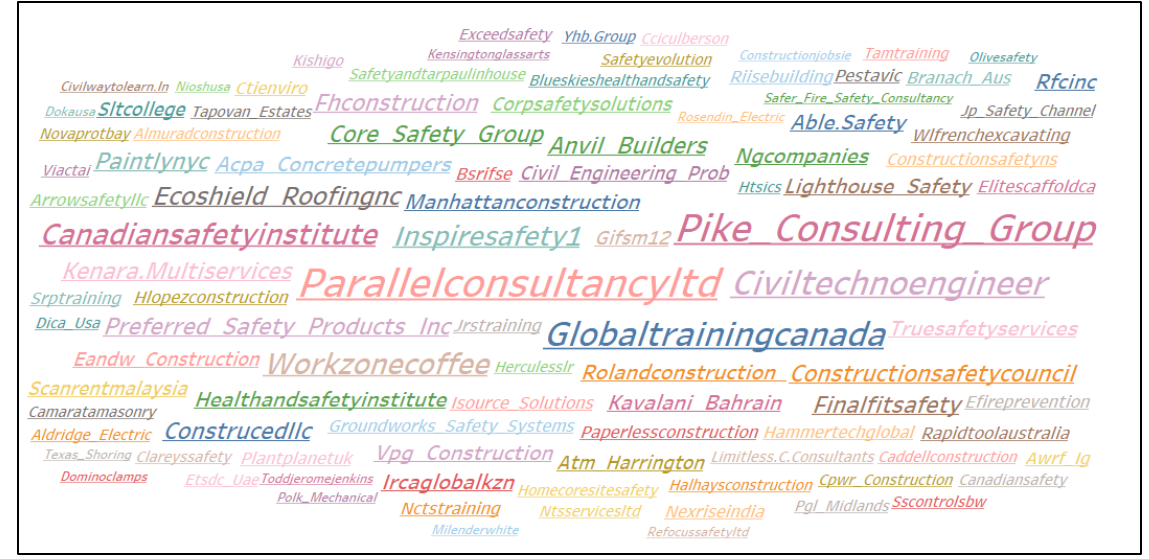
Figure 4. Influential users who mentioned construction health and safety on Instagram. Table 3. Influential users on construction health and safety on Instagram.